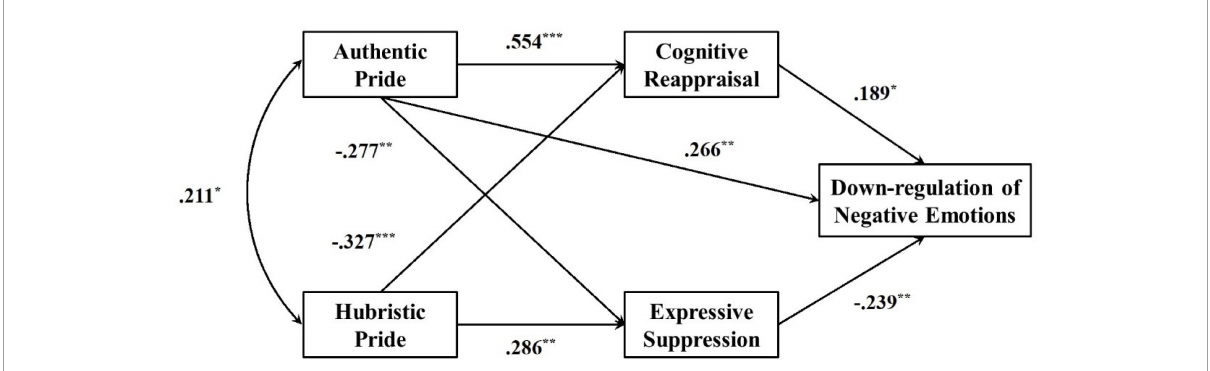
FIGURE1 Mediating effect model of two kinds of emotional regulation strategies (cognitive reappraisal; expressive suppression) between two facets of pride and down-regulation of negative emotions. *** p < 0.001, ** p < 0.01, * p < 0.05.